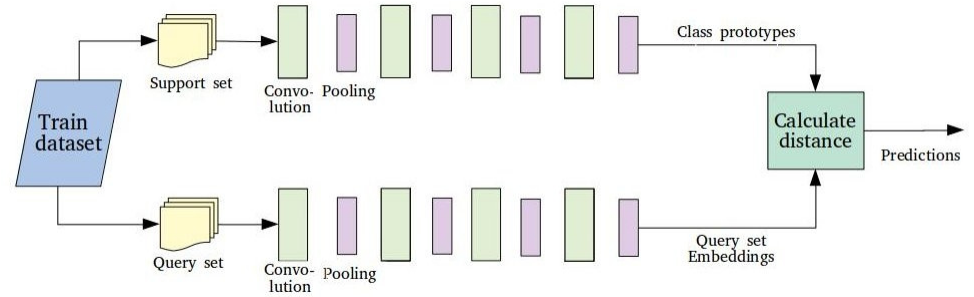
Figure 5. Methodological Workflow and Network Architecture for Model